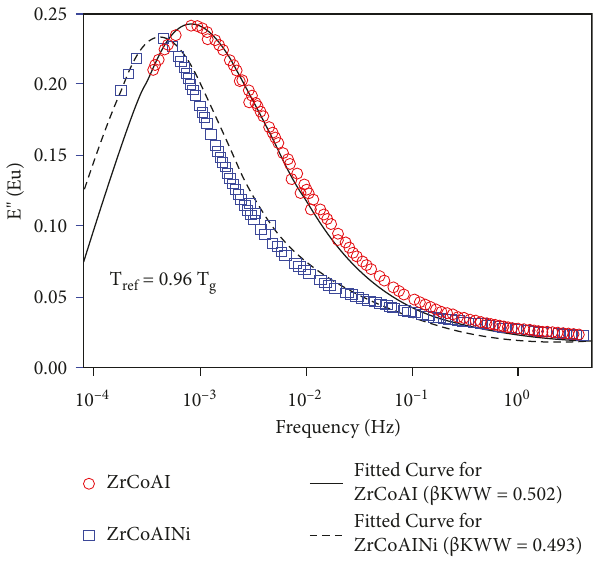
Figure 7: Master curves of ZrCoAl and ZrCoAlNi MGs fitted by the Bergman